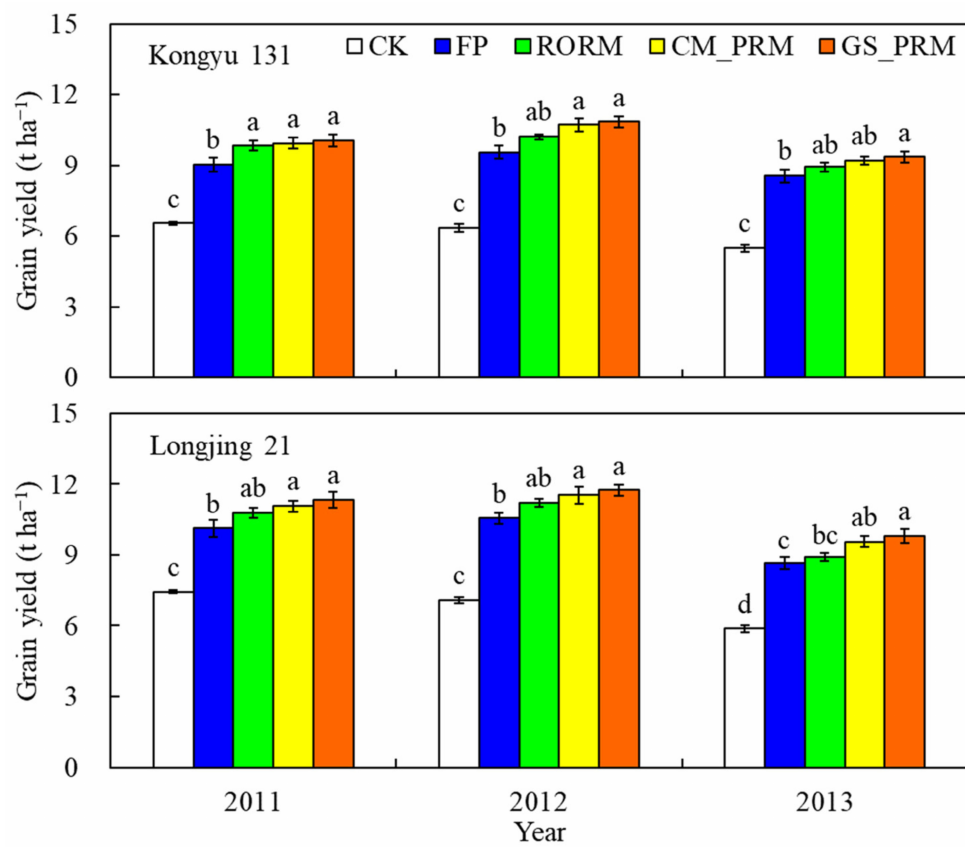
Figure 5. Grain yield in different rice management systems of two rice varieties, Kongyu 131 ( top ) and Longjing 21 ( bottom ), from 2011 to 2013. CK, FP, RORM, CM_PRM, and GS_PRM represent check treatment, farmer’s practice, regional optimum rice management, chlorophyll meter-based precision rice management, and GreenSeeker sensor-based precision rice management, respectively. Different letters indicate significant differences at p < 0.05 level in the same year. The error bars indicate the standard